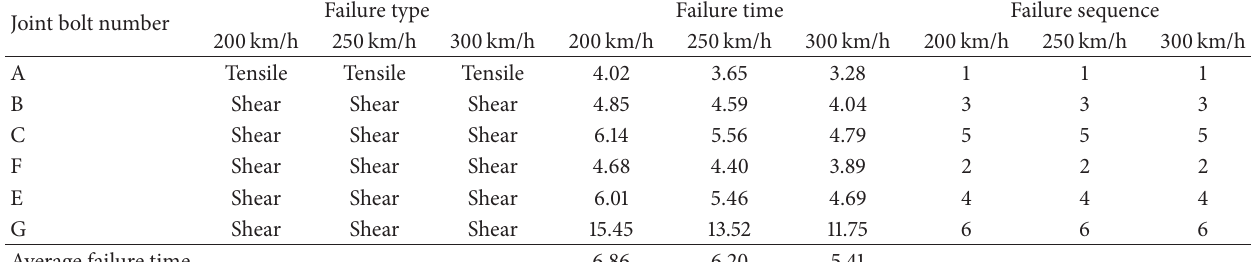
Table 8: Bolt failure behavior under different train running speeds.